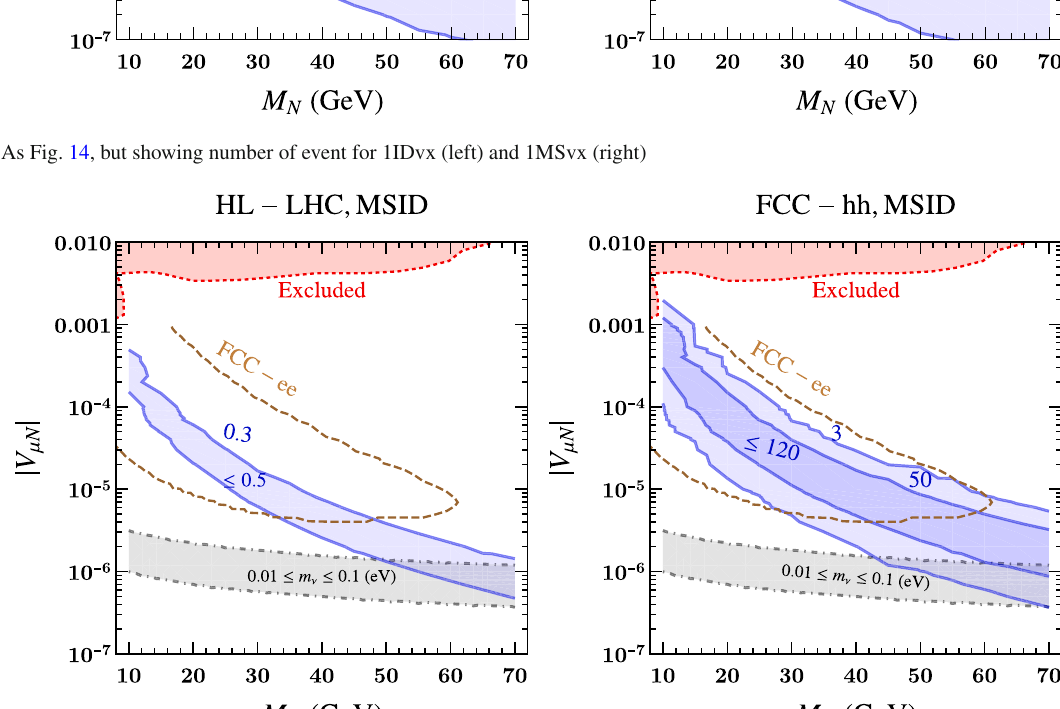
Fig. 16 As Fig. 14, but showing the number of 1IDvx-1MSvx events at the HL-LHC with L = 3 ab − 1 for M Z (cid:2) = 1 TeV, g (cid:2) = 3 × 10 − 3 (left) and at the FCC-hh with L = 30 ab − 1 for M Z (cid:2) = 8 TeV, g (cid:2) = 0 . 1